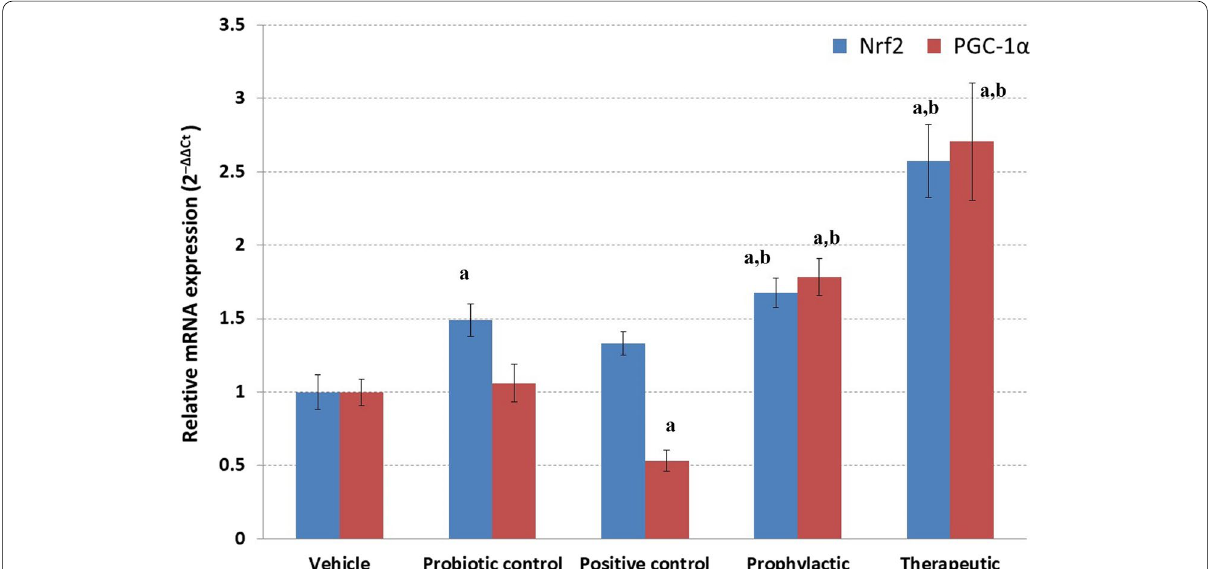
Fig. 4 Probiotic LGG enhances the expression of Nrf2 and PGC‑1 α . Expression of Nrf2 and PGC‑1 α was detected in the liver of different studied groups using real‑time PCR. Values were normalized to β‑actin. Relative mRNA expression was calculated using the comparative 2 − ΔΔCt method. a Significant p < 0.05 compared to the vehicle group. b Significant p < 0.05 compared to positive